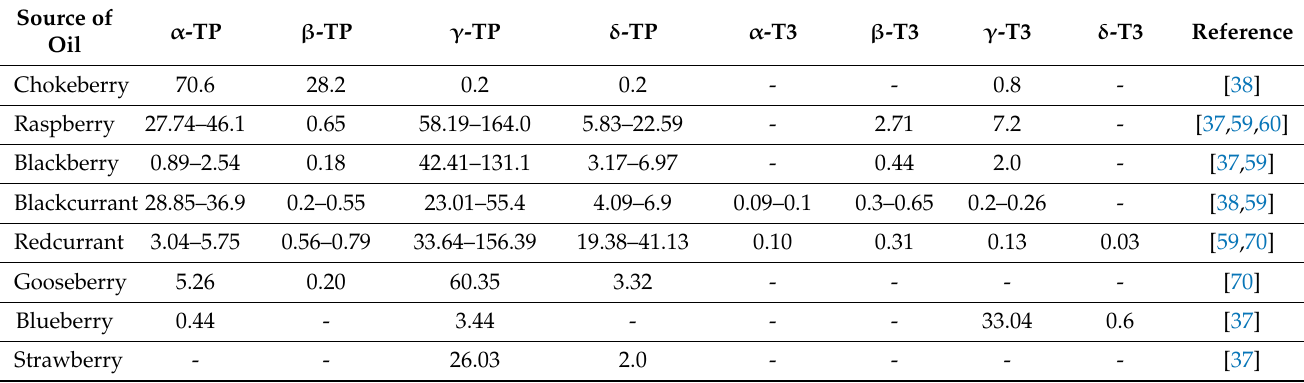
Table 2. Tocopherol composition of berry oils (mg/100 g oil). (TP- tocopherols; T3-